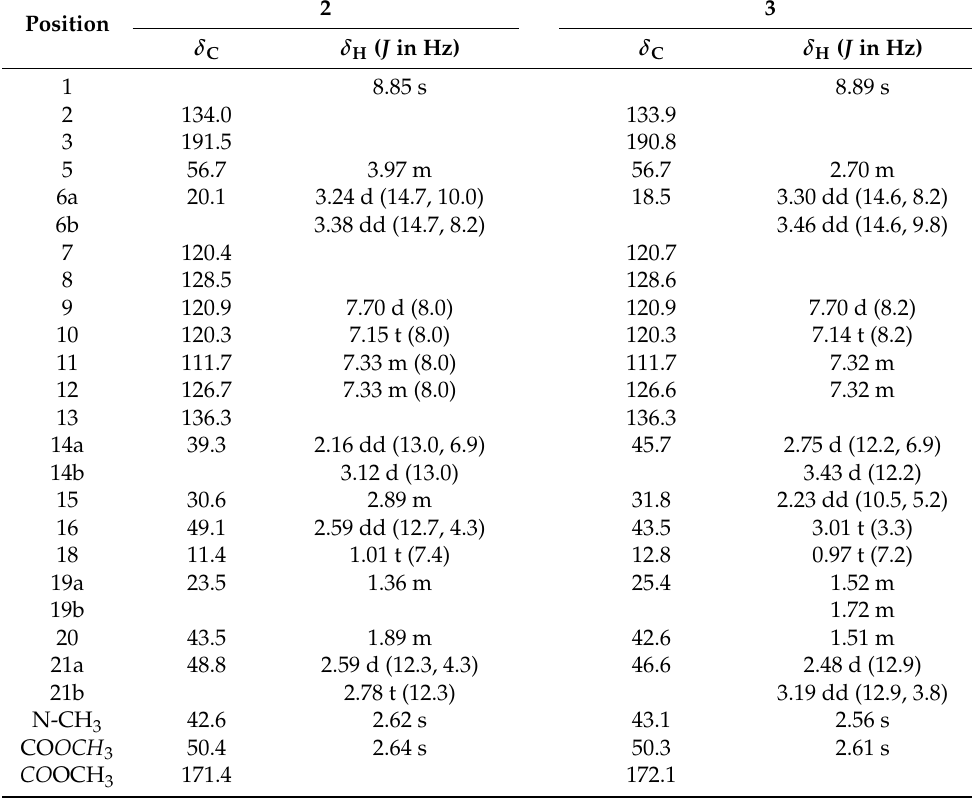
Table 2. 1 H and 13 C NMR data of compounds 1 and 4 (in CDCl 3